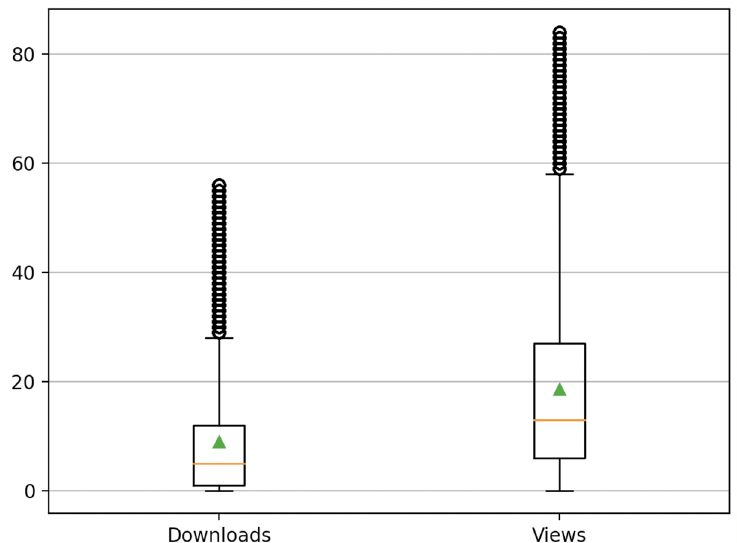
Figure A12. Humanities and social sciences datasets published in Zenodo (2015–2022): average total downloads and views.